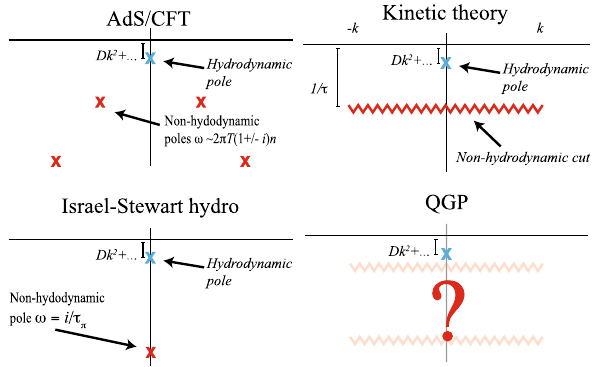
Fig. 1 Different analytic structures appearing in microscopic models of fluids. The presence of hydrodynamic poles in the long wavelength limit is a common feature of all Lorentz symmetric theories with self- interactions. On the contrary, the structure of the non-hydrodynamic sector closely reflects the underlying microscopic degrees of